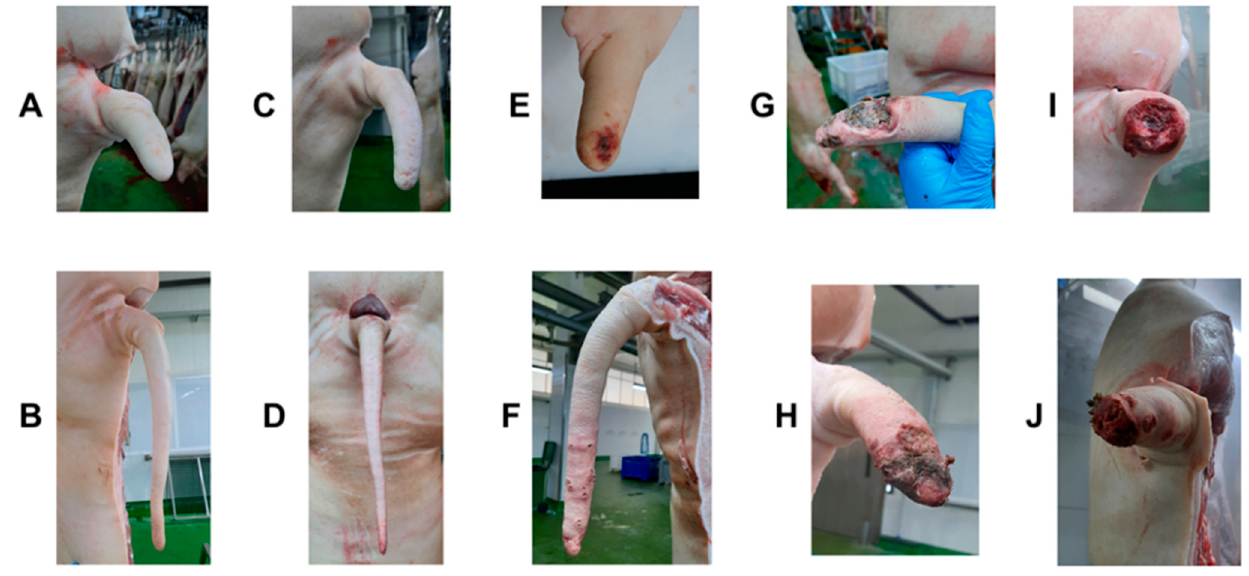
Figure 1. Example pictures of tails scored according to the tail lesion scoring system used (See sec- tion Tail Scores for details): ( A , B ) Score 0—No evidence of tail biting; ( C , D ) Score 1— Superficial lesions only, without the presence of blood; ( E , F ) Score 2—Presence of puncturing wounds associ- ated with tail bites, with possible presence of blood or inflammation; ( G , H ) Score 3—Extended le- sion associated with chewing with partial loss of tail tissue but with no loss of tail length; ( I , J ) Score 4—Extended lesion associated with chewing with loss of tail length.